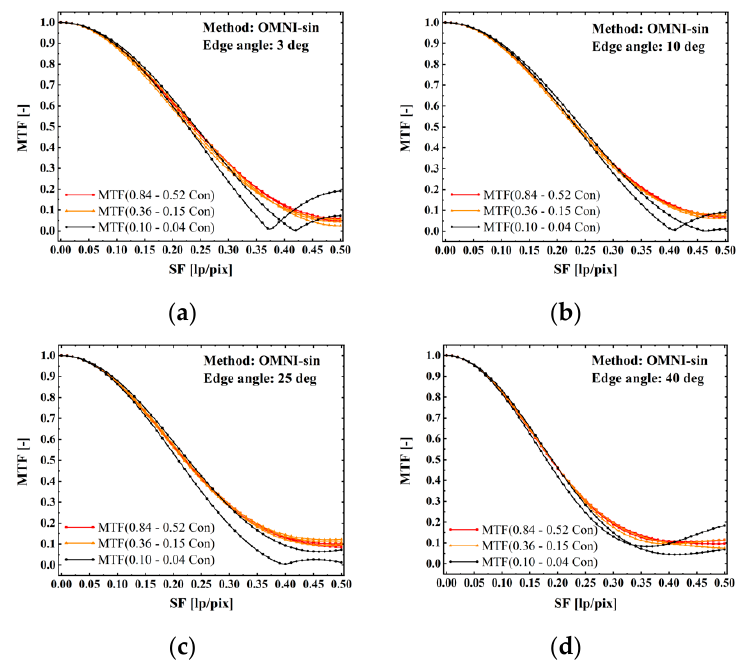
Figure 14. MTF for some tilt angle BDE@Con images when adopt different edge contrast using OMNI-sin edge method: ( a ) when edge angle is 3 deg, ( b ) when edge angle is 10 deg, ( c ) when edge angle is 25 deg, ( d ) when edge angle is 40 deg.